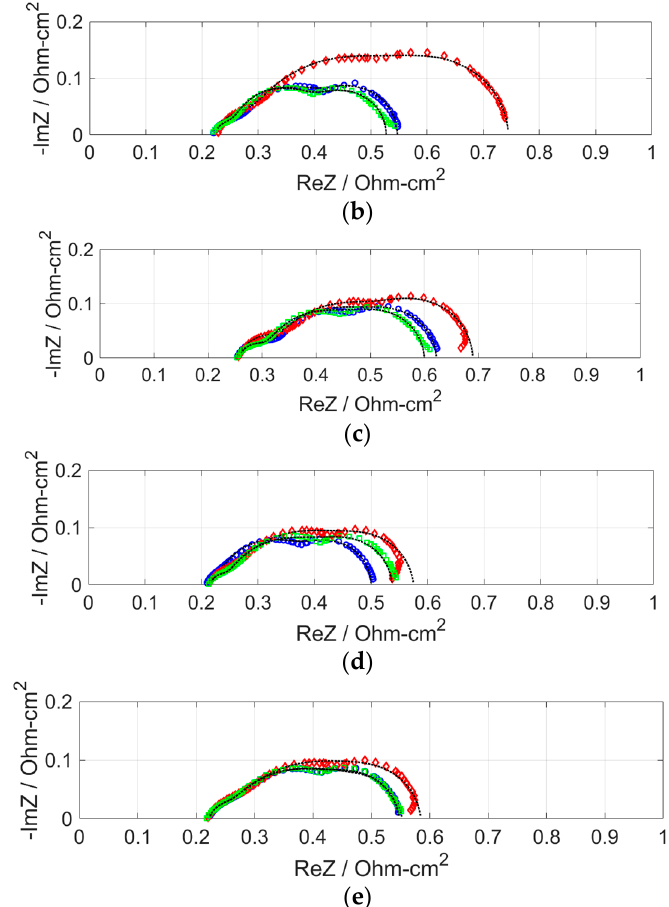
Figure 4. Effect of H 2 S on AC impedance of MEAs under various Pt loadings measured at current density of 0.48 A cm − 2 : ( a ) 0.3; ( b ) 0.4; ( c ) 0.5; ( d ) 0.6; and ( e ) 0.7 mg cm − 2 . ( □ : pure H 2 ; ◇ : H 2 S; ○ : H 2 recovery; -- : fitted line).